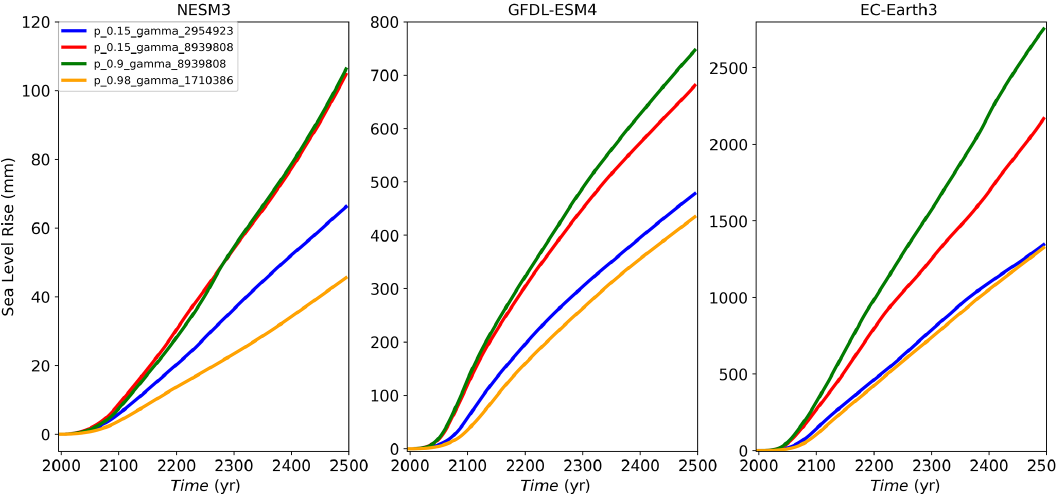
Figure A1. Sea level rise experiment using low (NESM3, a ), moderate (GFDL–ESM4, b ) and high (EC–Earth3, c ) CMIP6 climate scenarios, showing results using p/γ 0 values that are low/low (blue), low/high (red), high/high (green), and high/low (orange). The results show the following: (1) with low p and high gamma the sea level response is similar compared to the high p and high γ 0 combination for low and moderate forcing; (2) p does influence the results under high forcing scenarios; (3) the sea level response with low p and high γ 0 is always larger compared to the response with high p and low γ 0 , highlighting the strong influence of γ 0